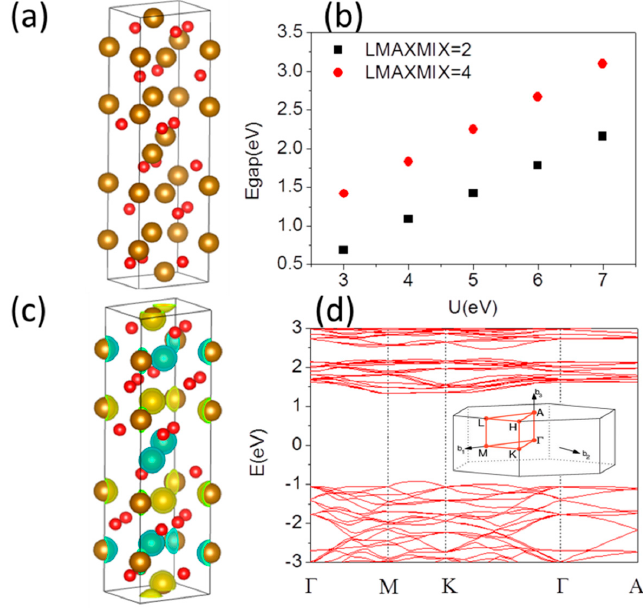
Figure 1. ( a ) The lattice geometry of α -Fe 2 O 3 bulk from side view, the yellow and red color is marked for Fe and O; respectively; ( b ) band gap of α -Fe 2 O 3 bulk as a function of U parameter of Coulomb interaction; ( c ) magnetic spin density at isosurface level at 0.2 e/Å 3 with light yellow and green color for up and down spin, respectively; and ( d ) band structure of α -Fe 2 O 3 bulk for lattice constant a = 4.9158 Å at U = 5 eV with Γ (0.00, 0.00, 0.00), M(0.00, 0.50, 0.00), K( − 0.33, 0.67, 0.00), and A(0.00, 0.00, 0.50). The Fermi level is set to zero and band gap is 2.224 eV.